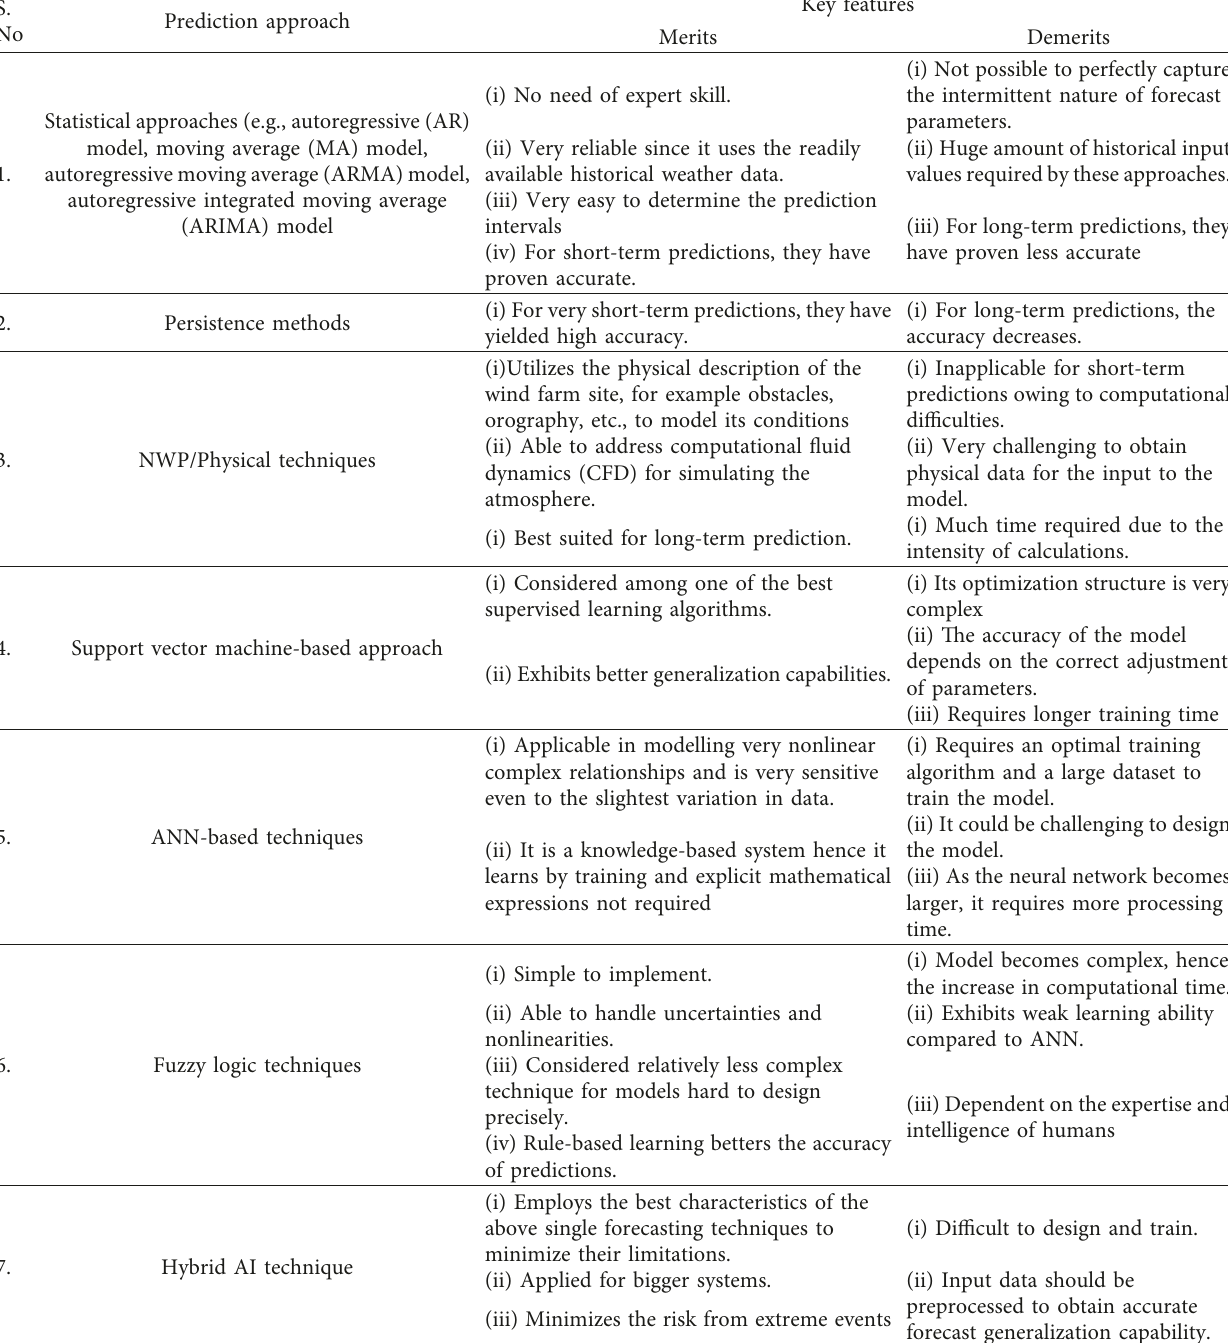
Table 1: Comparison of different wind forecasting techniques